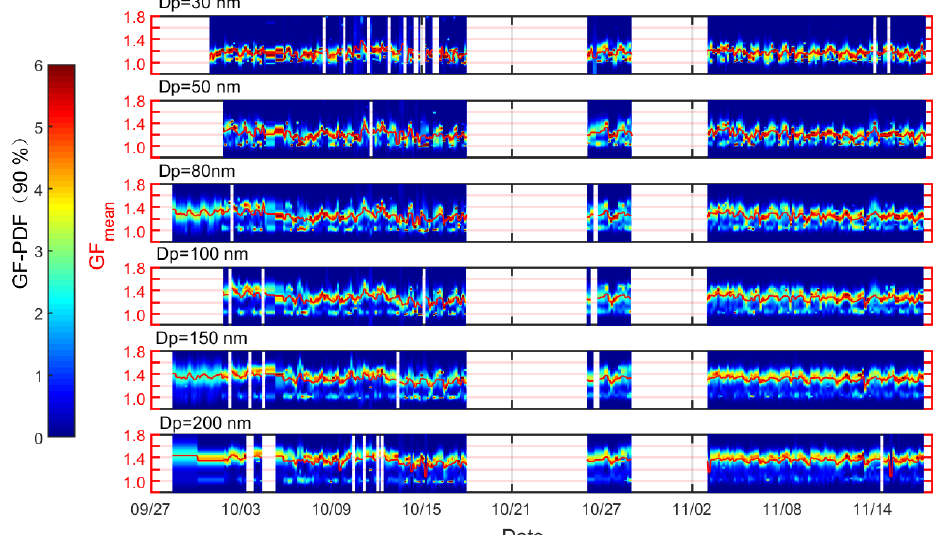
Figure 2. The temporal profile of GF-PDF at the measured diameters (30, 50, 80, 100, 150, and 200nm). The color code denotes the probability density, and the red solid line represents the mean GF (GF mean